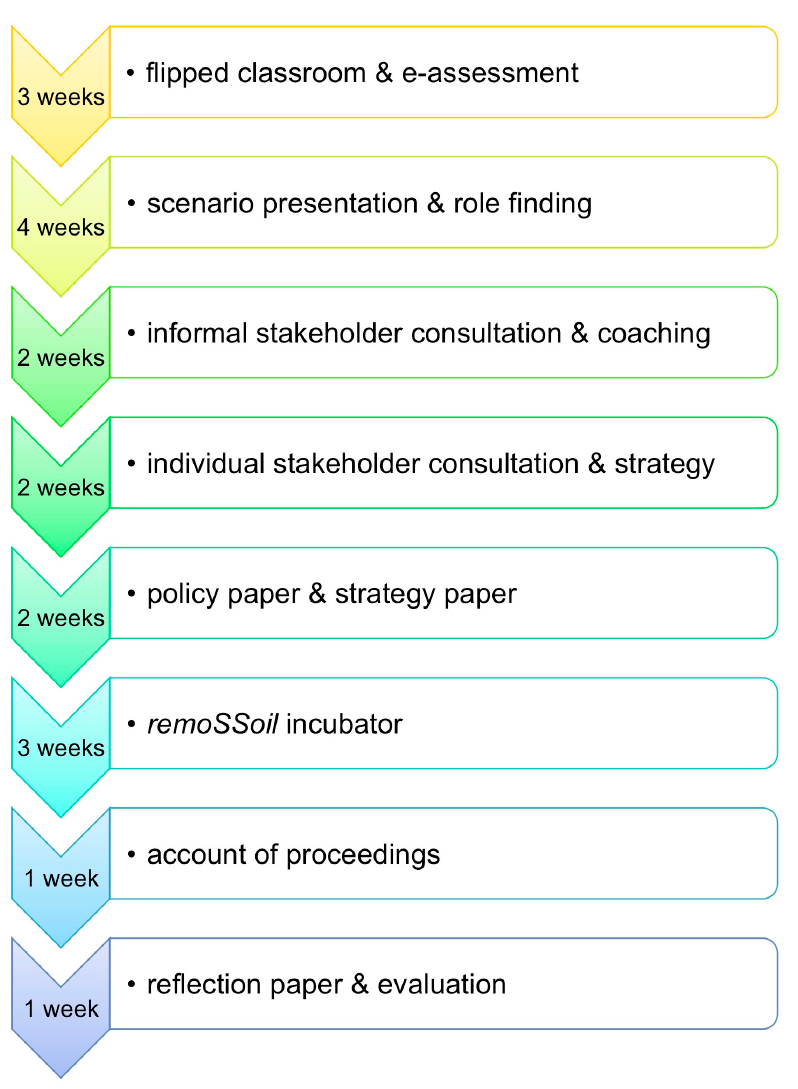
Figure 2. Stages of the remoSSoil simulation game.